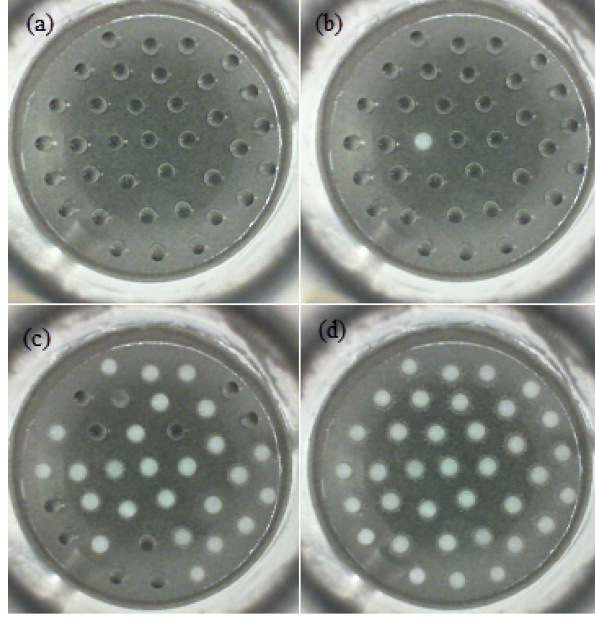
Figure 2. The progression of a µl-NIPI freezing experiment. The ex- periment shown used a dispersion containing 0.01wt% K-feldspar. (a) was taken at around − 10 ◦ C, shortly before the onset of freez- ing; (b) immediately after the first droplet had frozen; (c) at − 14 ◦ C and (d) at − 20 ◦ C, after the completion of freezing. The top left of (c) shows a droplet in the process of freezing. Droplets of this size typically take 2–4s to freeze completely, proceeding much faster at lower temperatures. The initial change in the droplet leading to freezing is taken as the occurrence of ice